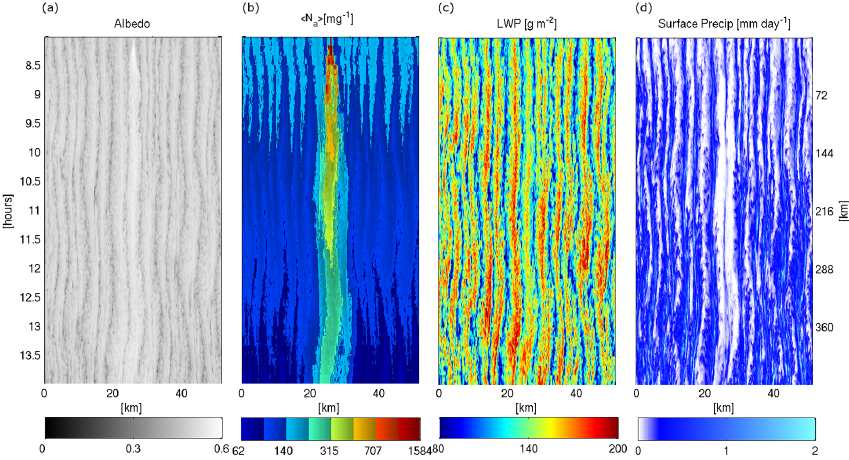
Figure 16. x – t Hovmöller plot for run SensHiAer; panels as in Fig.